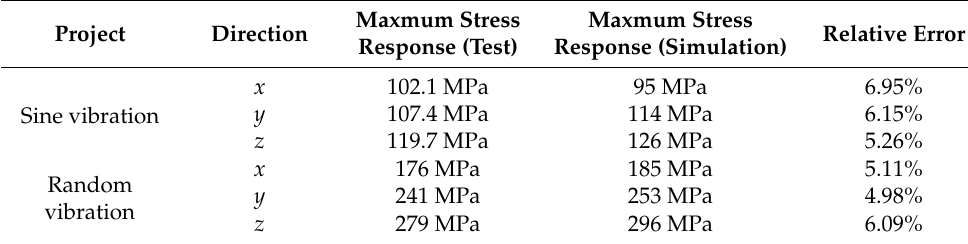
Table 7. Comparison between test and simulation of stress response.